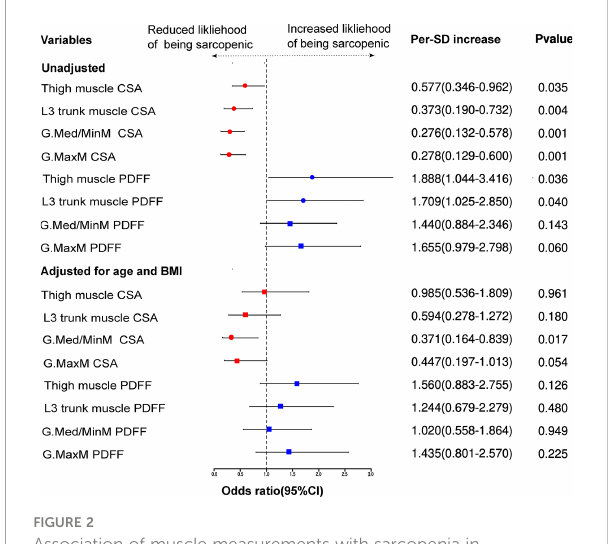
FIGURE 2 Association of muscle measurements with sarcopenia in hemodialysis patients. P < 0.05 was considered statistically signi fi cant. CI, con fi dence interval; L3 trunk, third lumbar trunk; G.Med/MinM, gluteus medius and minimus muscles; G.MaxM, gluteus maximus muscle; PDFF, proton-density fat-fraction. circle = signi fi cant; square = non-signi fi